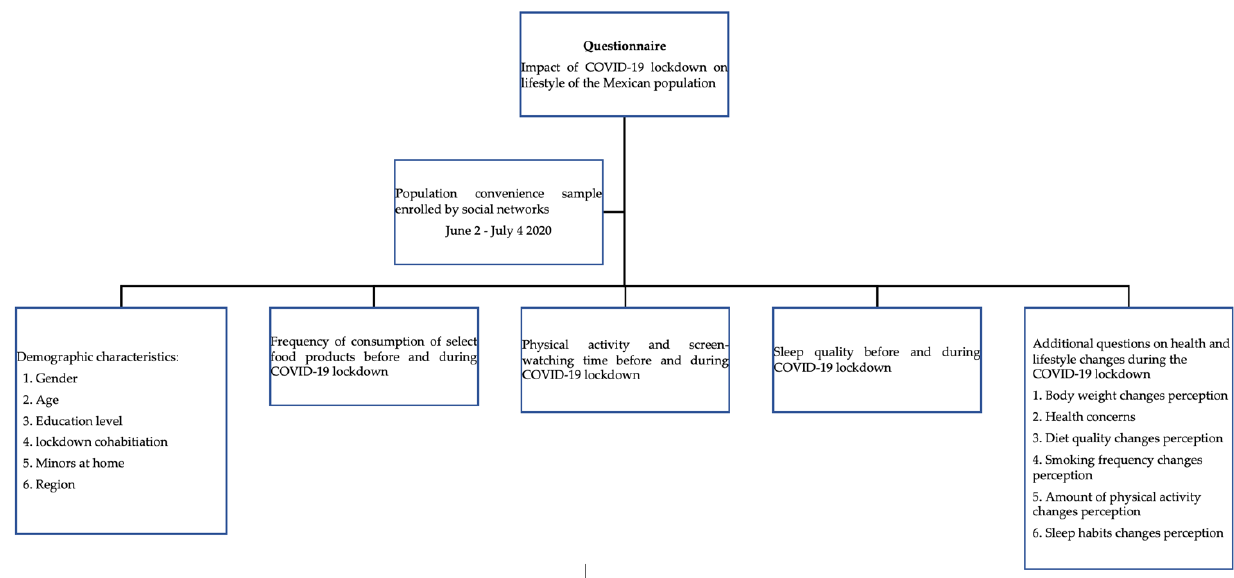
Figure 1. Schematic representation of the study participants and sections of the online questionnaire.